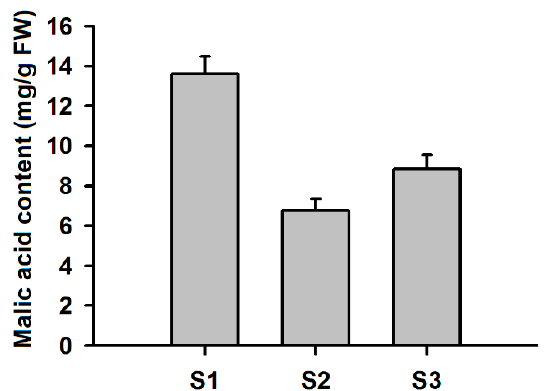
Figure 7. Changes in malic acid concentration in fruits of apple during development. S1, S2 and S3 represent juvenile stage, expanding stage and mature stage of fruit development, respectively. FW, fresh weight.